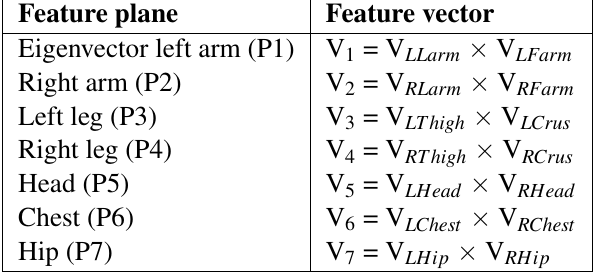
Table 1 Discriminant vectors on the feature plane.